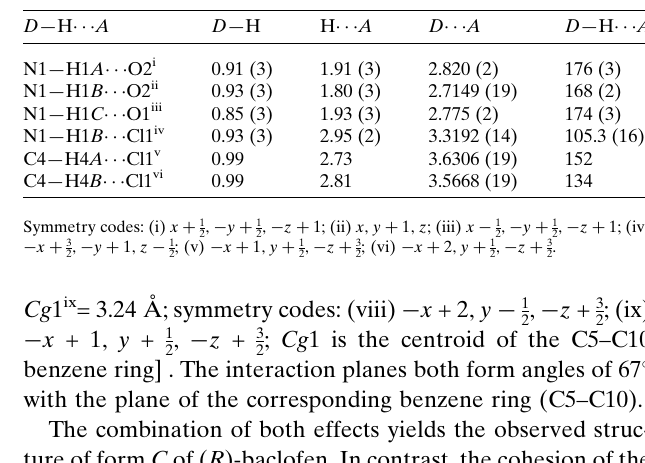
Table 1 Hydrogen-bond geometry (A˚ , (cid:4) ).